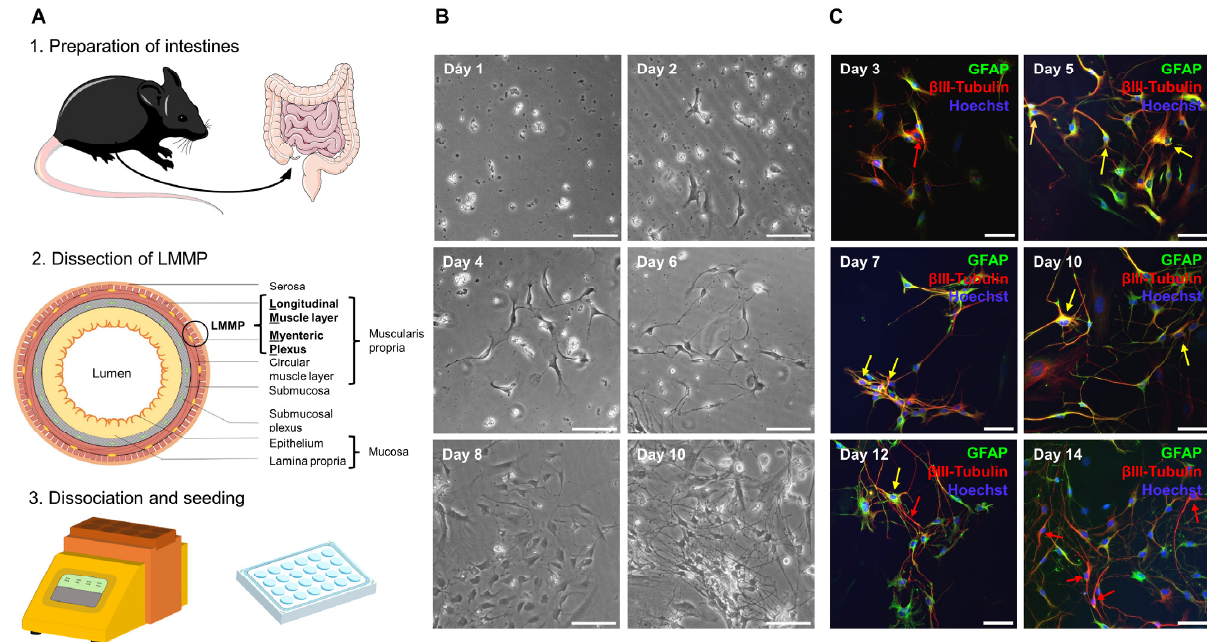
Figure 2. Establishment of a primary enteric nervous system culture. ( A ) Complete intestine from duodenum to rectum was removed, cleared of feces, and rinsed. Pieces that were 2–4 cm in length were threaded onto a glass rod and incised longitudinally. Then, the outer longitudinal muscle layer with attached myenteric plexus (LMMP) was dissected. LMMP was digested with collagenase and trypsin using the Miltenyi gentleMACS TM Octo Dissociator with heaters. Cells were plated onto coated coverslips in a 24-well plate. The figure was partly generated using Servier Medical Art, provided by Servier, licensed under the Creative Commons Attribution 3.0 Unported license. ( B ) Cells began to adhere after 24 h. After 2 d, processes began to form and grow before cells started proliferating at approximately day 8. On day 10, a stable network had formed. Scale bars represent 100 µm. ( C ) Cells in culture expressed the marker proteins glial fibrillary acidic protein (GFAP) and β III-tubulin. Immediately after culture preparation, few neuronal cells could be detected (red arrows). From day 5 onward, cells expressing both markers were visible (yellow arrows). From day 10 onward, coexpression decreased and more neuronal cells were detected. Scale bars represent 50